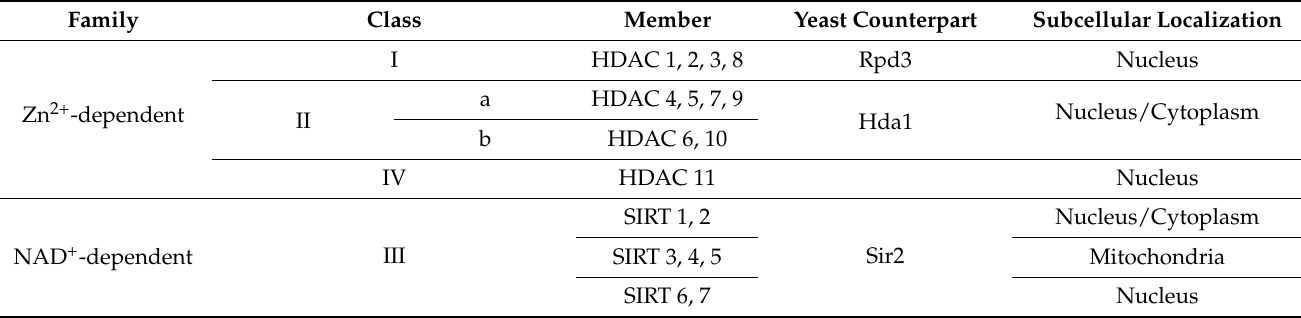
Table 1. Classification of HDACs and their subcellular